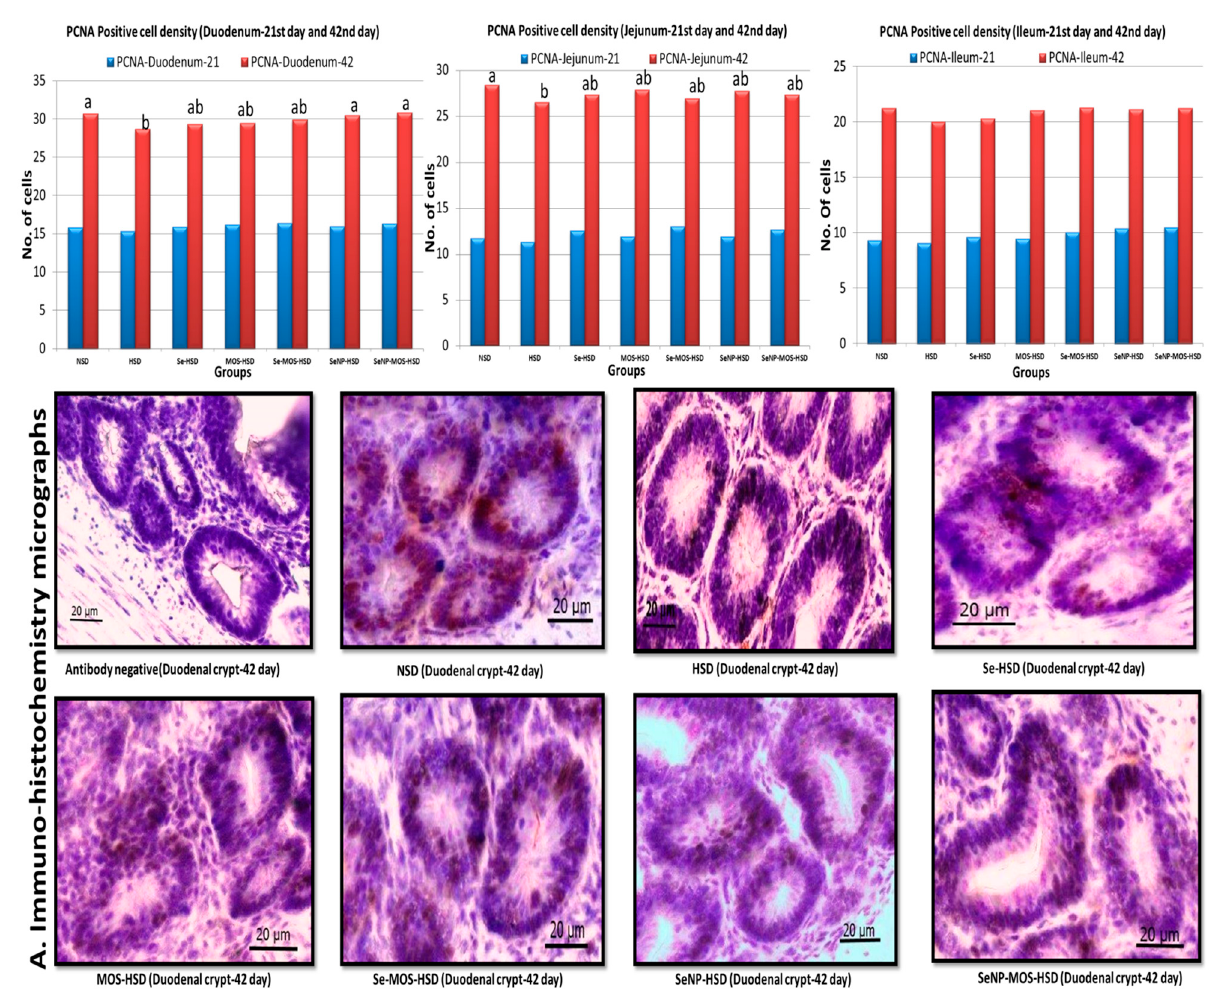
Figure 2. Graphs comparing the proliferating cell nuclear antigen-positive cell density in the segments of small intestine on day 21 and day 42 among groups. The data bar height shows the number of PCNA-positive cells per crypt in the two-dimensional image. These values represent the means of eight replicates per group (16 birds per group). NSD: normal stocking density, HSD: high stocking density, Se: selenium selenite, MOS: mannan oligosaccharide, SeNP: selenium nanoparticles. PCNA: proliferating cell nuclear antigen bar of the same color with different letters differs significantly between groups. A. Immuno-histochemistry micrographs (40×) showing proliferating cell nuclear antigen positive cells in duodenal crypts.